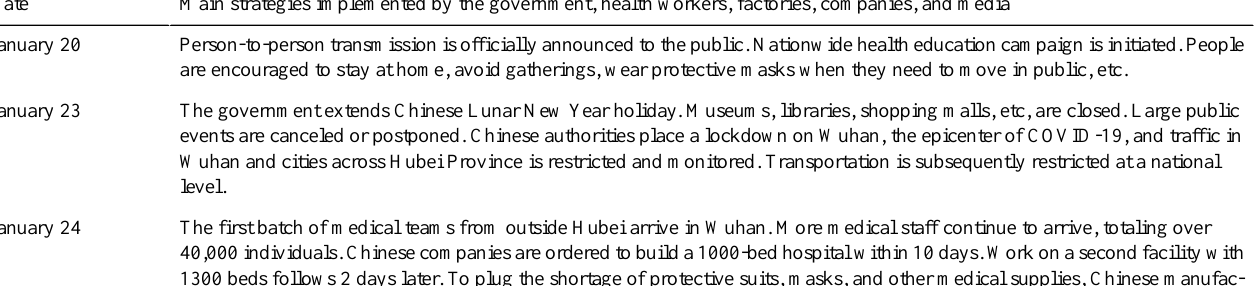
Table 6. Main public strategies that responded to coronavirus disease 2019 (COVID-19) epidemic in China. Main strategies implemented by the government, health workers, factories, companies, and mediaDate Person-to-person transmission is officially announced to the public. Nationwide health education campaign is initiated. People